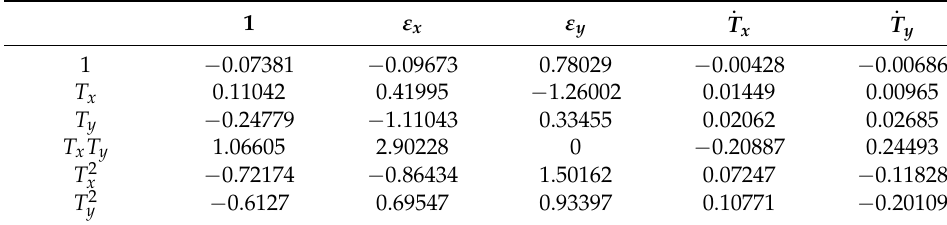
Table 5. Fitting results for (cid:101) K ty , tx .